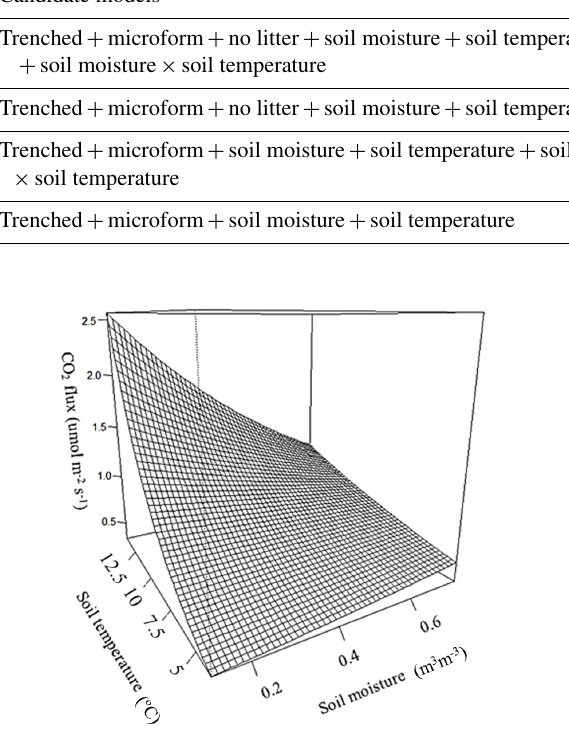
Figure 4. Combined effect of soil temperature and soil moisture at 5cm depth on soil CO 2 flux from the control sites, estimated from the top model.